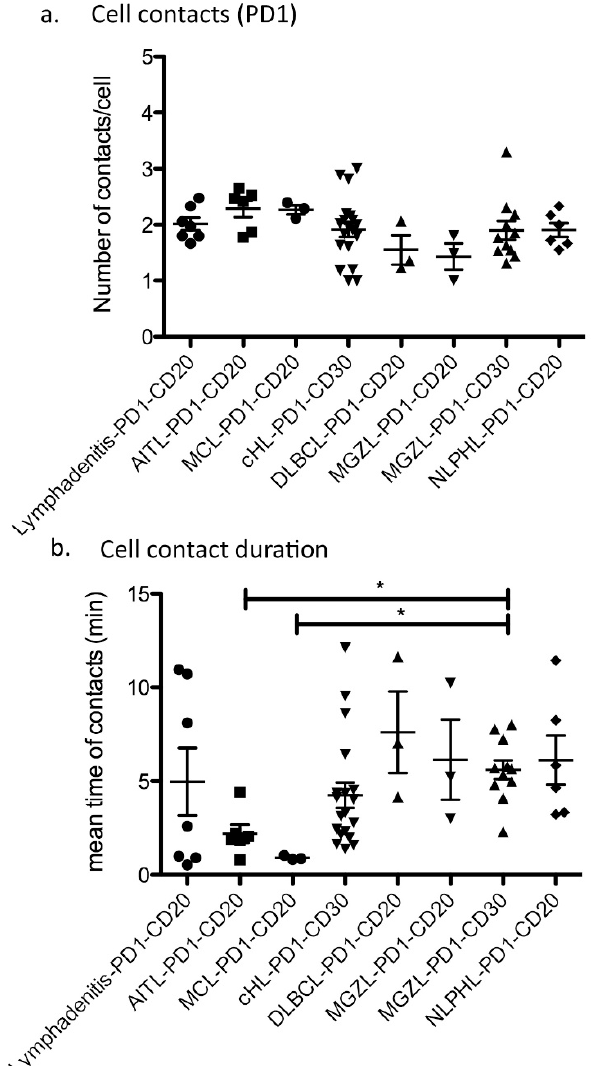
Figure 3. Cell–cell contacts between tumor and bystander cells. ( a ) Number of cell–cell contacts per movie between tumor cells (CD20 or CD30 as indicated) and PD1-positive T cells (for AITL PD1- positive tumor cells and CD20-positive B cells). Each dot represents the mean from one movie. Lym- phadenitis: 4 cases, AITL, DLBCL, NLPHL and MCL: one case, MGZL: two cases, cHL: three cases. ( b ) Duration of cell–cell contacts between tumor (CD20 or CD30 as indicated) and PD1-positive T cells (for AITL PD1-positive tumor cells and CD20-positive B cells, * p < 0.05, Kruskal–Wallis test with Dunn’s post-test for multiple comparisons). Each dot represents the mean from one movie.